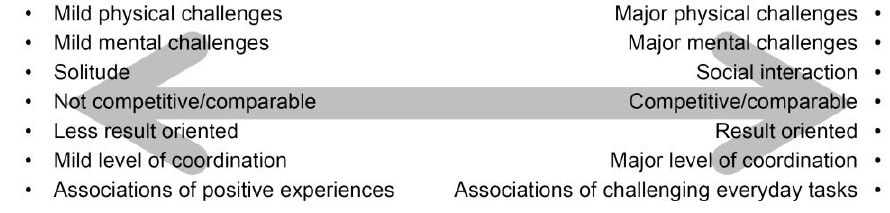
Figure 11. Polarization of the participants’ narratives about activities carried out in Nacadia ® .